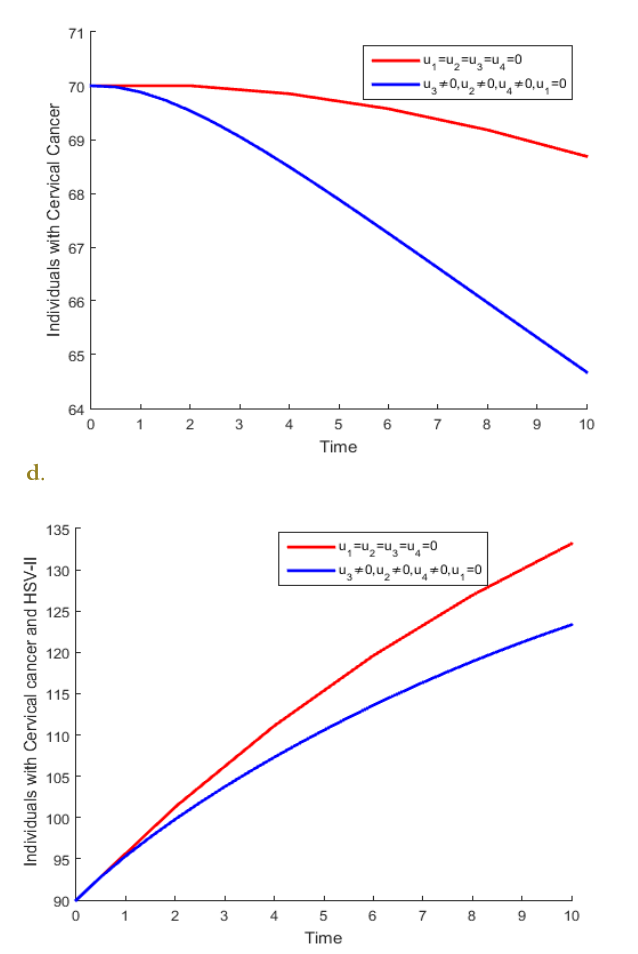
Fig. 1. Simulations showing optimal use of HSV-II prevention, HPV treatment and HSV-II treatment. Intervention II. Optimal use of HPV prevention, HPV treatment and HSV-II